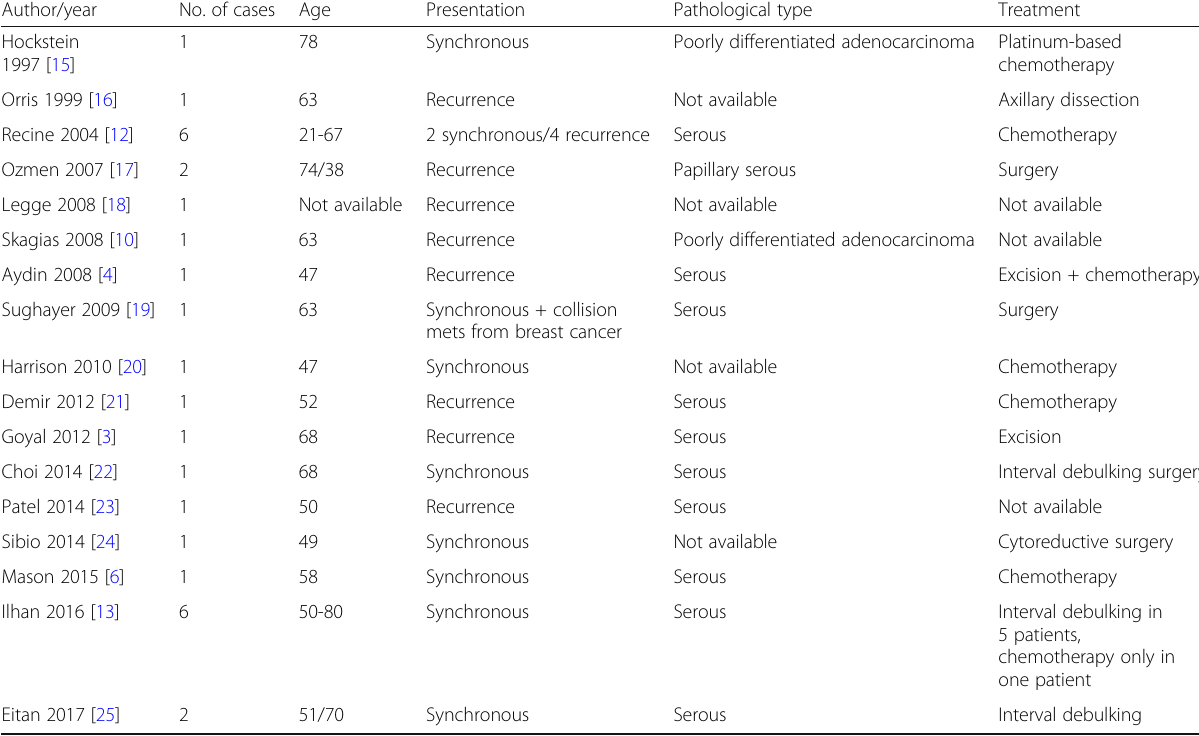
Table 1 Literature review of previously reported cases of metastatic ovarian carcinoma to axillary lymph